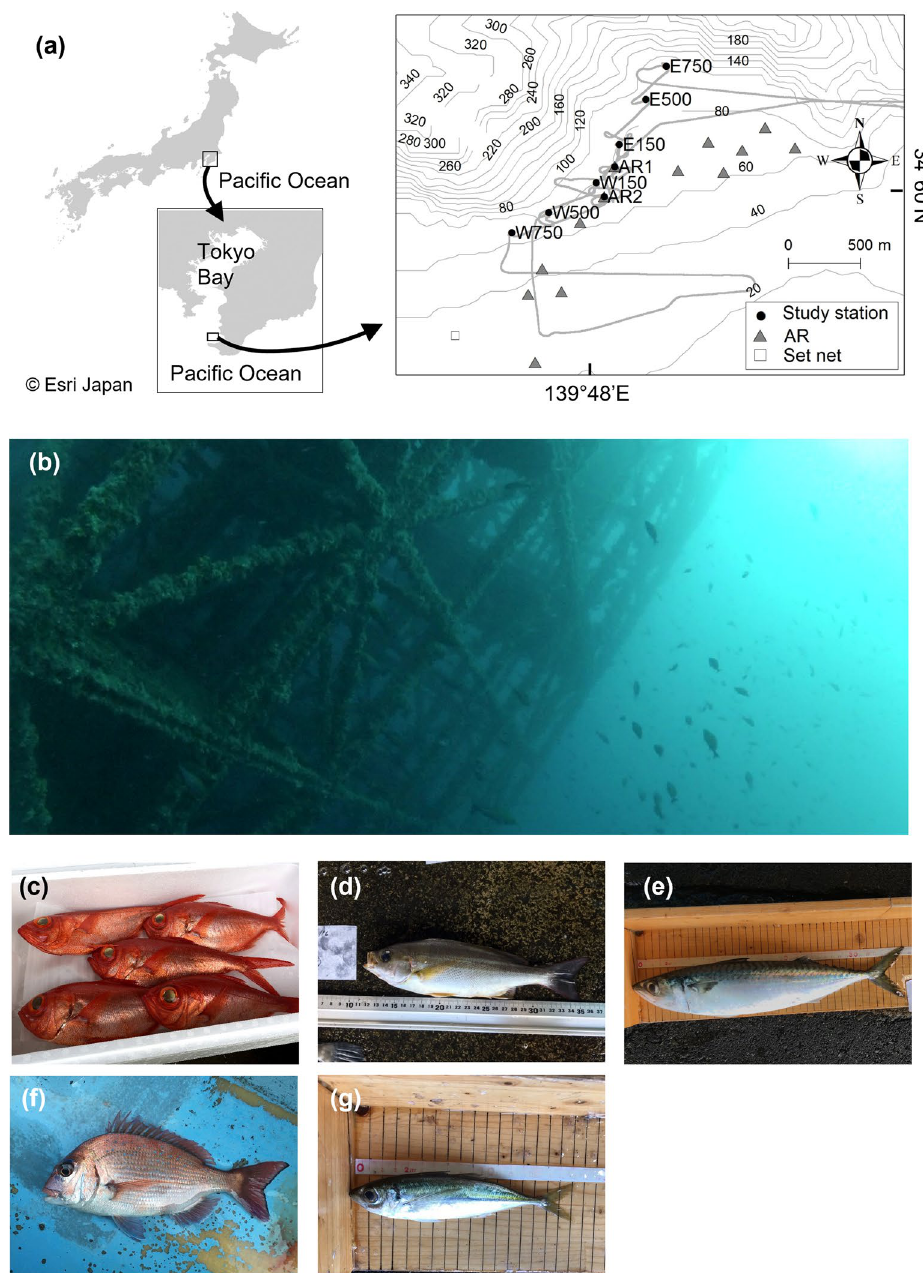
Figure 1. ( a ) Location of sampling stations, cruise track, and a set net in Tateyama Bay. Gray areas indicate landmasses, a gray bold line indicates cruise track, and gray thin lines indicate depth contours with an interval of 20 m. The maps were created using ArcGIS Software 10.6.0.8321 by ESRI (https:// www. esri. com/) based on the municipal boundary data of Japan (Esri Japan) and Global Map Japan (Geospatial information Authority of Japan) as well as the M7000-series isobath data set (Japan Hydrographic Association). A picture of the artificial reef (AR1) ( b ) taken one year after this survey (June 2019) and pictures of the dominant species, ( c ) splendid alfonsino ( Beryx splendens ), ( d ) chicken grunt ( Parapristipoma trilineatum ), ( e ) chub mackerel ( Scomber japonicus ), ( f ) red seabream ( Pagrus major ), and ( g ) jack mackerel ( Trachurus japonicus ). Photograph credits: ( b ) Nariaki Inoue, ( c ) Fumie Yamaguchi, ( d , e , g ) Yutaro Kawano, and ( f ) Masaaki